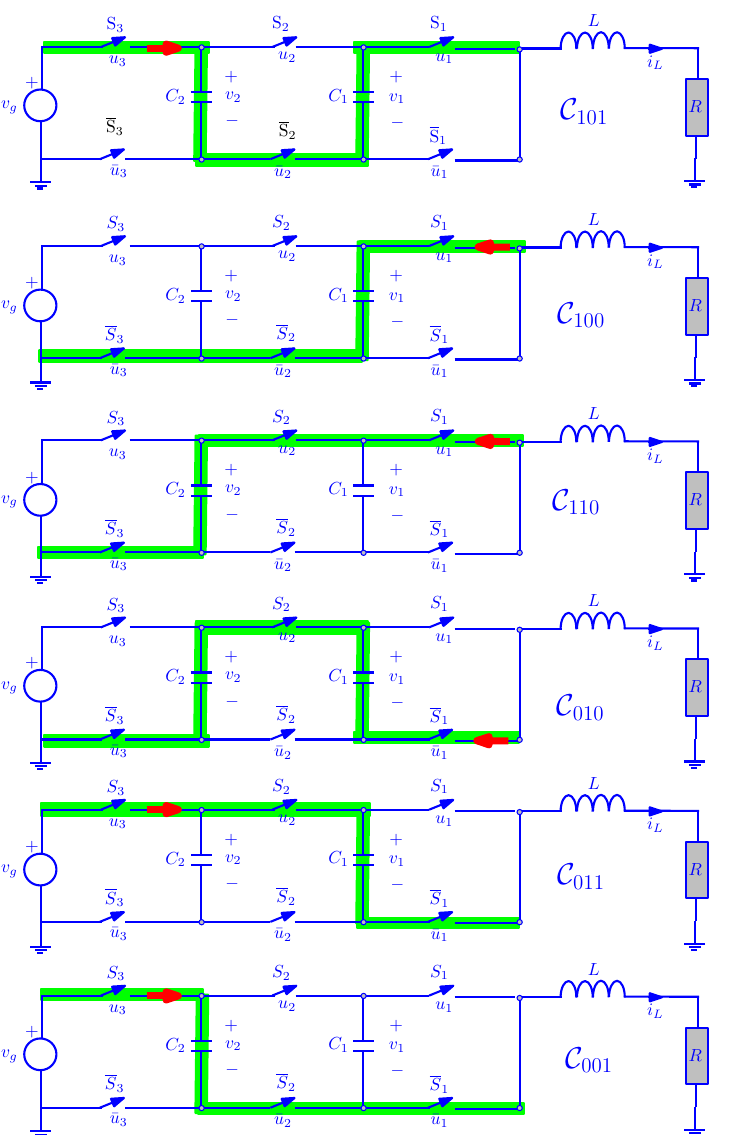
Figure 4. Configurations used by the flying capacitor three-cell buck converter for steady-state duty < D < 2 cycle in the range 1 . Green color indicates the current path and the red arrows stands for 3 3 power flow